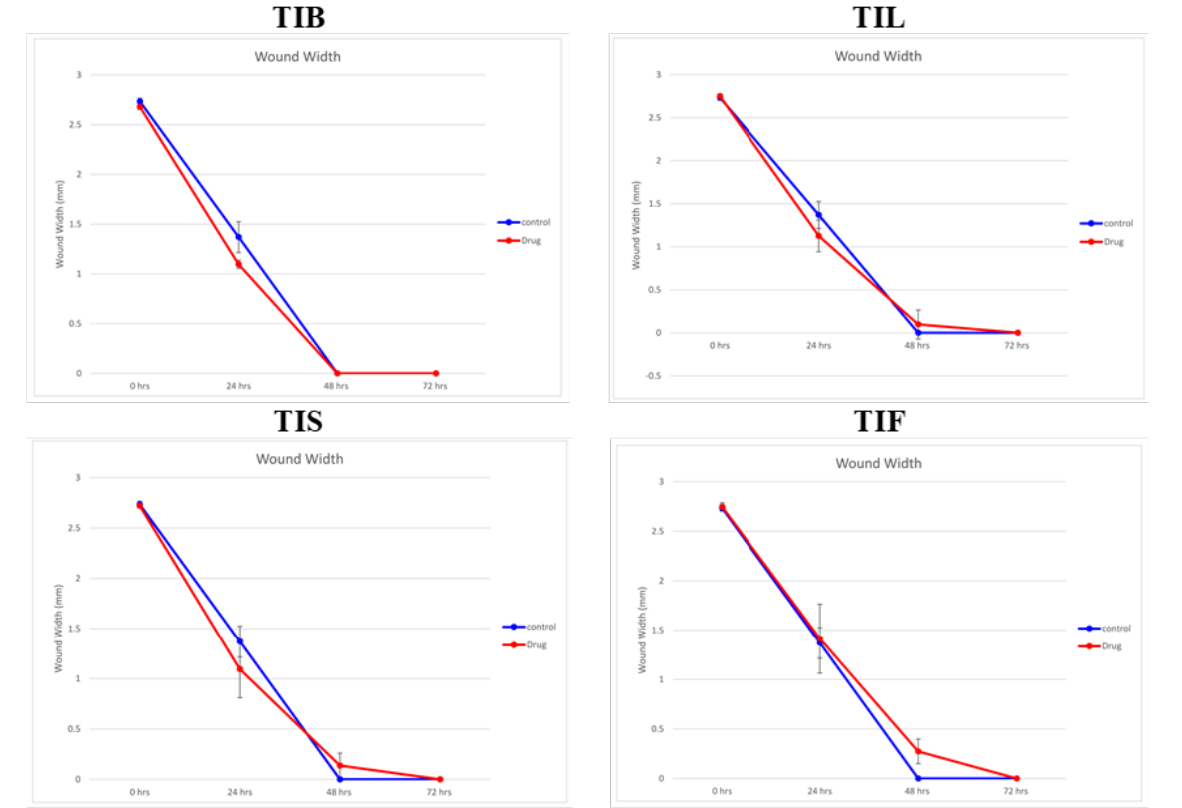
Figure 5. The wound width changes in the absence or presence of 10 µg/mL of n -hexane extract from various organs of T. indica : TIB (bark), TIL (leaves), TIS (seeds), and TIF (fruits). After 24 h, the highest wound healing potential was recorded by TIB and TIS n